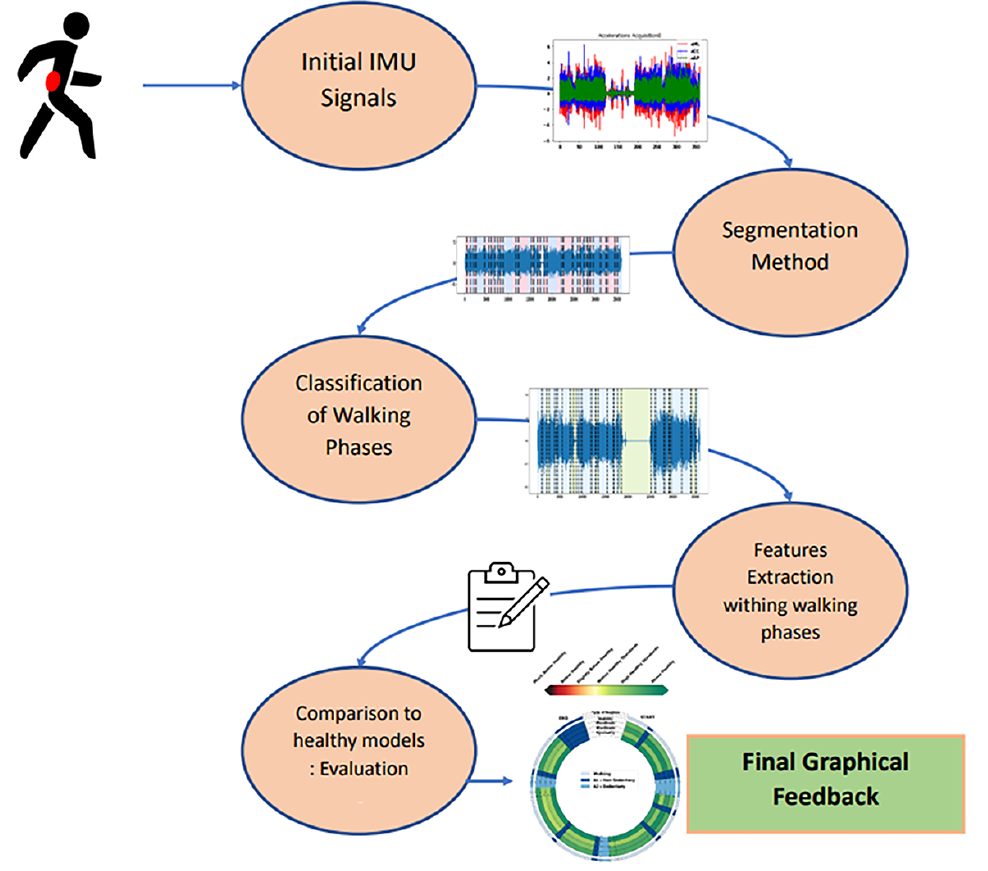
Figure 1. Successive steps of our processing pipeline to render a graphical feedback from a semi- FLE